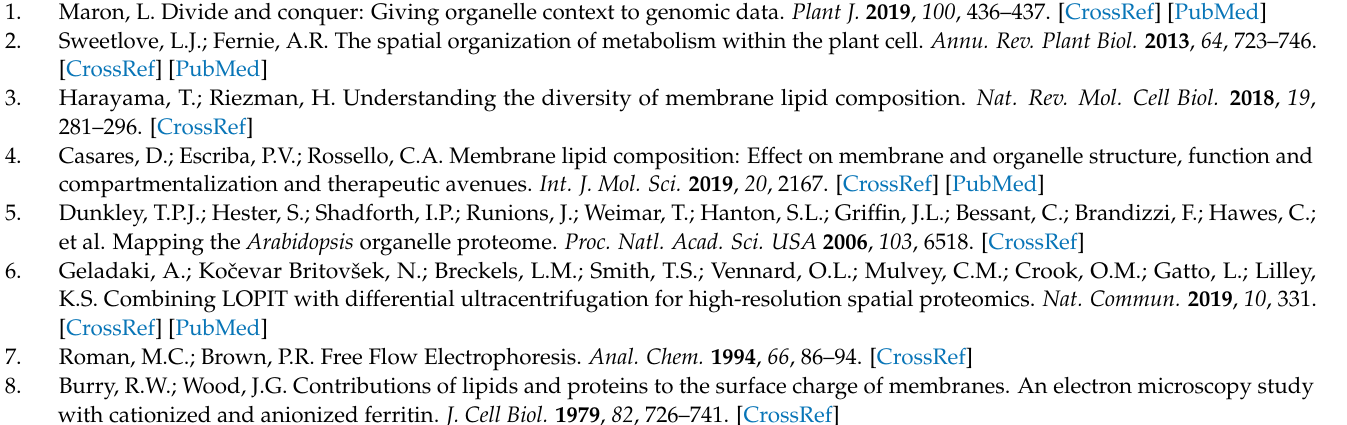
programs, Table S2: Functional annotation and subcellular localization of identified proteins, Table S3: Digital western FFE profiles of Ras-related